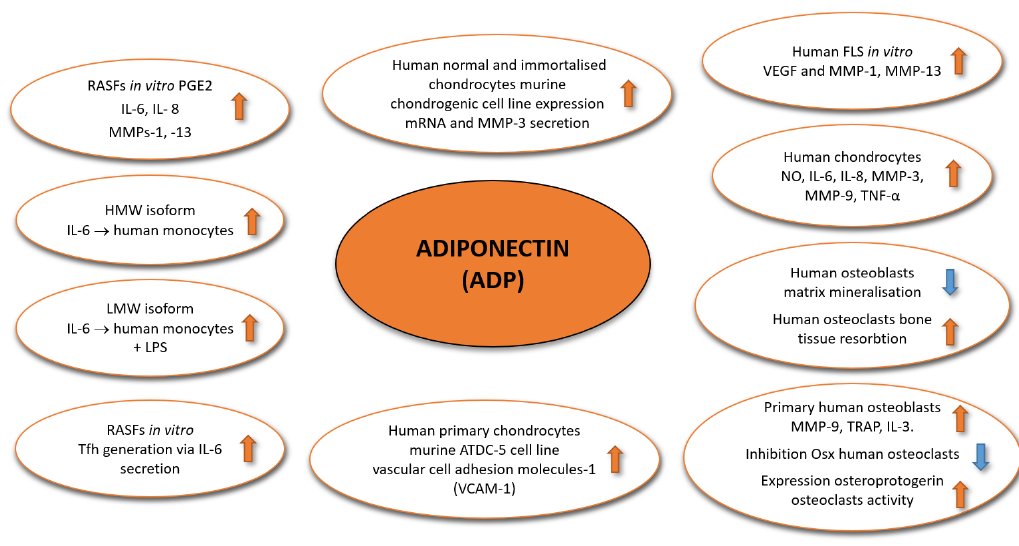
Figure 2. The e ff ects of adiponectin and its isoforms on various cell types in Figure 2. The effects of adiponectin and its isoforms on various cell types in RA. Table 1. Selected studies investigating the association of adiponectin and rheumatoid arthritis in humans, cell cultures, and animals.